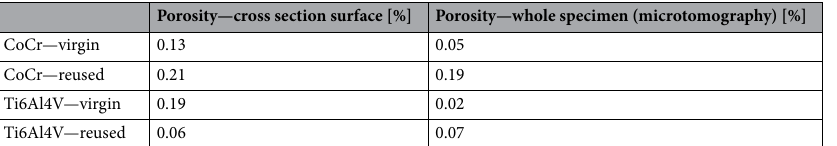
Table 6. Porosity measurements for the CoCr and Ti6Al4V specimens printed with virgin and reused powder, determined on polished surfaces by optical microscope and